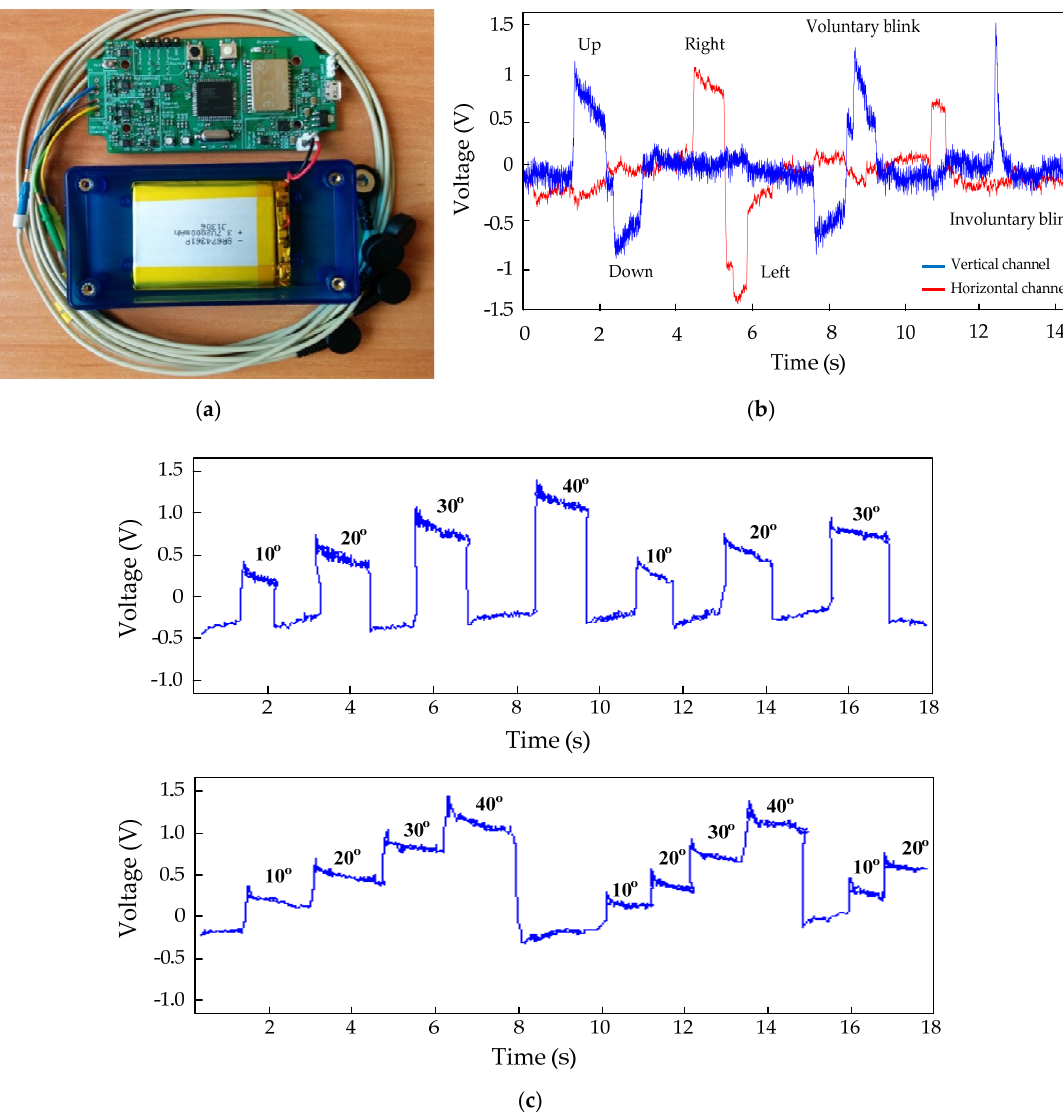
Figure 10. ( a ) A photo of the EOG system; ( b ) Characteristic EOG potential changes due to eye movement; ( c ) Saccadic movements corresponding to a 0°–10°–20°–30°–40° gaze sequence.